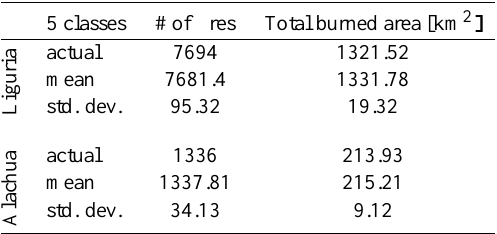
Table 2. Comparison between observed number of fires, total burned area, and simulated distribution of the same parameters ob- tained by MFFM (5 classes). The mean values and the standard deviation of the number of fires and the total burned area obtained simulating 1000 different trials are reported for the 2 considered regions.